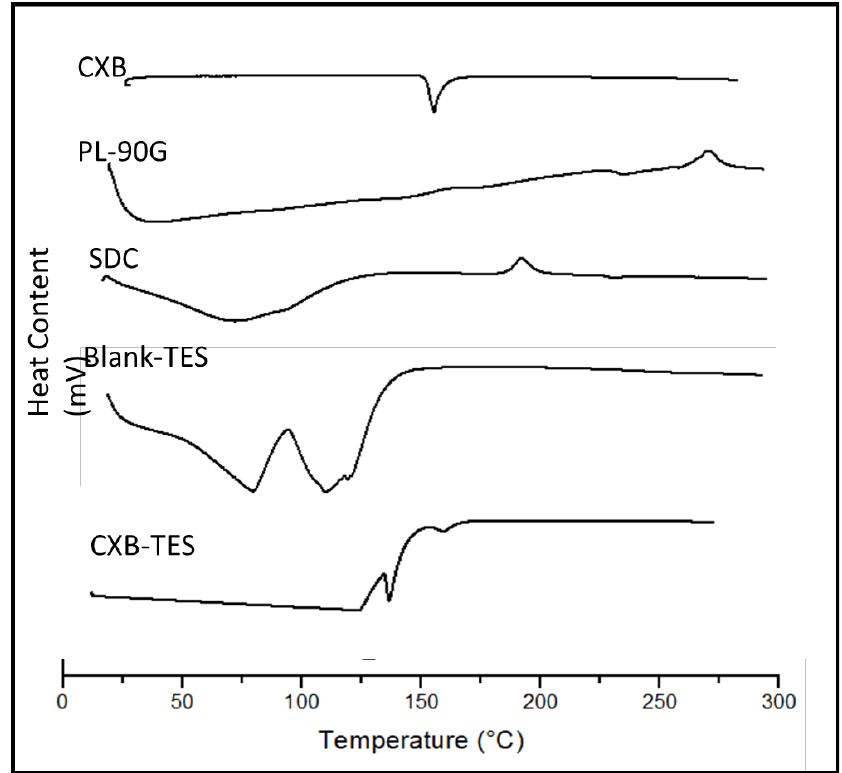
Figure 1. Differential scanning colorimetry (DSC) of CXB powder, PL-90G, SDC, Blank-TES, and the selected CXB-TES (F4).